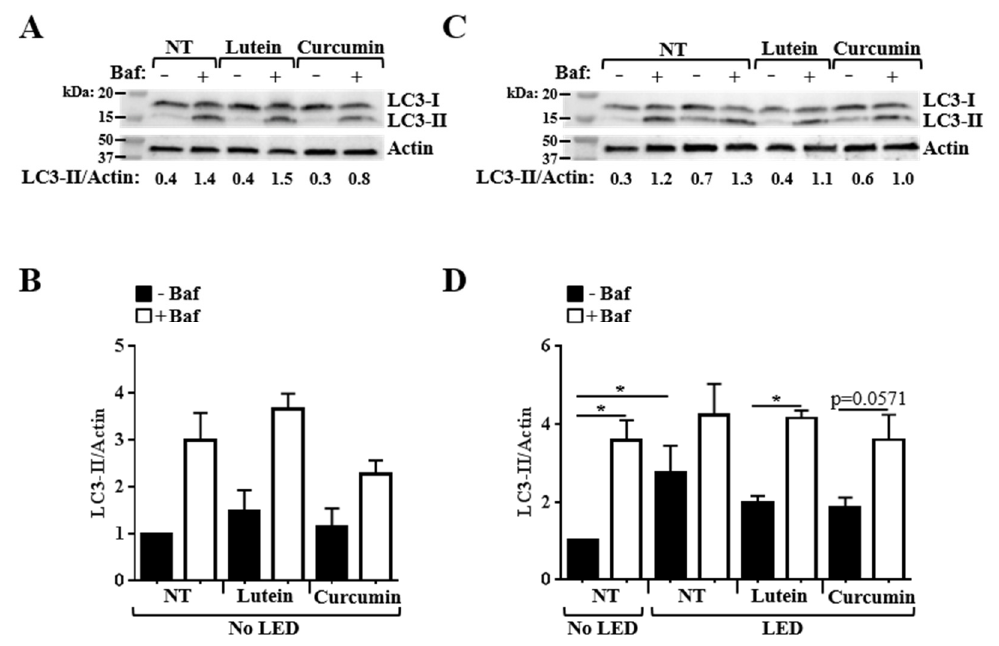
Figure 8. E ff ect of lutein and curcumin on autophagy. ARPE-19 cells were treated with lutein at 3.5 µ M and curcumin at 3.4 µ M for 24 h before being exposed or not to blue LED for 4 h. Bafilomycin A1 (Baf) was added 2 h before protein extraction. Immunoblot analyses were performed using anti-LC3B and anti-Actin antibodies. Quantification of LC3-II and Actin was done. ( A , C ) are representative immunoblots. ( B , D ) are the corresponding ratios of LC3-II / Actin normalized to that obtained for cells that were untreated, non-exposed to blue LED and without Baf, defined as 1.0. Data are means ± SEM of at least 3–4 independent experiments. For statistical analysis, comparisons were performed between untreated cells with Baf and cells treated with lutein or curcumin, with Baf by using the non-parametric Mann–Whitney test. Comparisons were also performed between cells without Baf or cells with Baf, in the di ff erent conditions (untreated, or treated with lutein or curcumin), by using the non-parametric Kruskal–Wallis test. * p < 0.05.